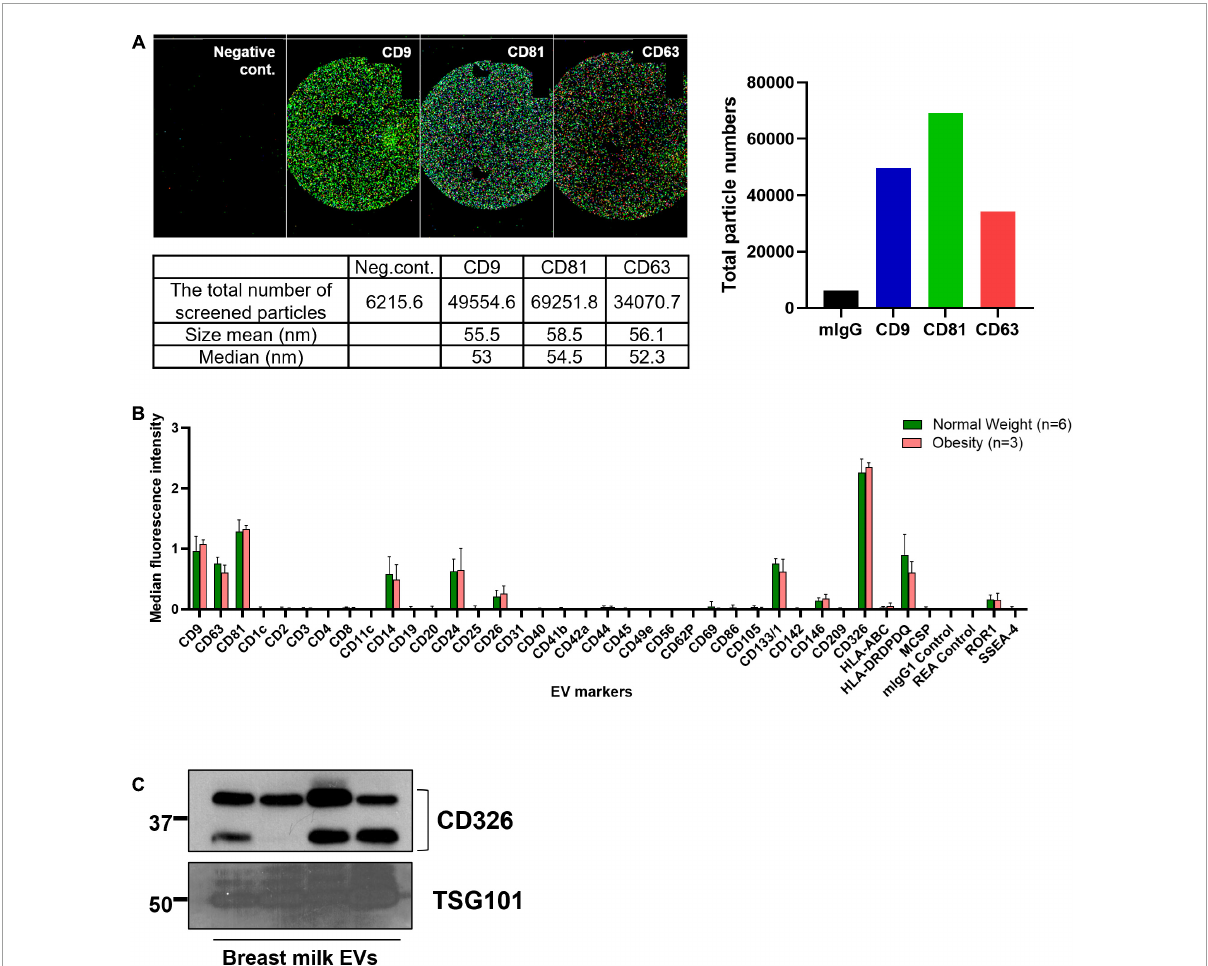
FIGURE1 Characteristics of breast milk EVs (bEVs). (A) Particles expressing three EV markers (CD9, CD81, and CD63) were examined using NanoView R100 ( n = 8). The representative images show the colocalization of these three EV markers; CD9 in dark blue; CD81 in green; and CD63 in red. mIgG is a negative control. The size range of EVs expressing these markers is 50–60 nm. (B) The median fluorescence intensity of EV markers was calculated after background correction with negative controls,and the intensity was compared between groups. (C) The expression level of CD326 and TSG101 in bEVs was confirmed with western blotting ( n = 4).